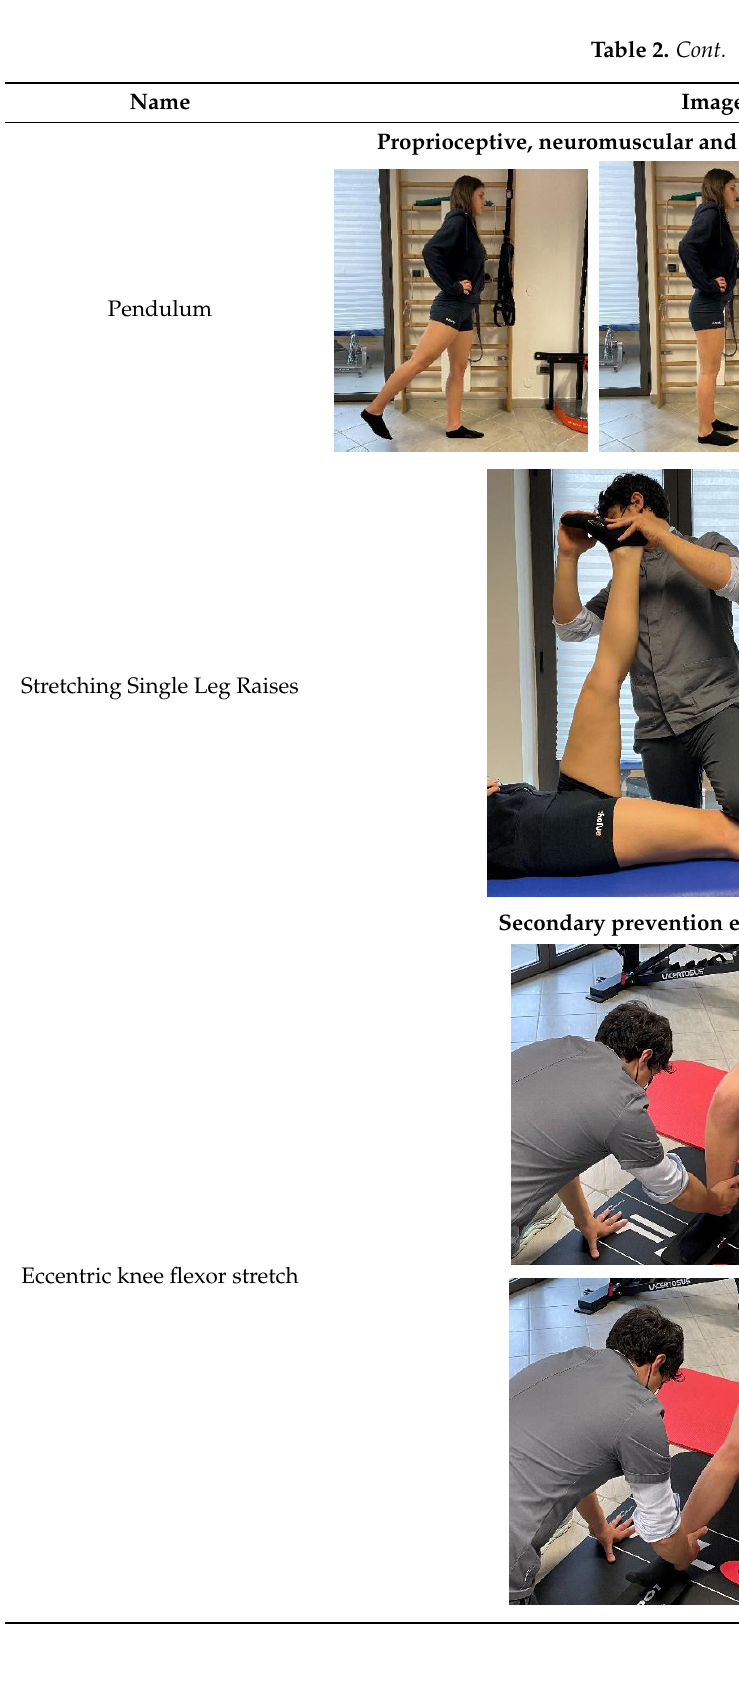
Quadriceps Table 3. Quadriceps rehabilitation exercises.